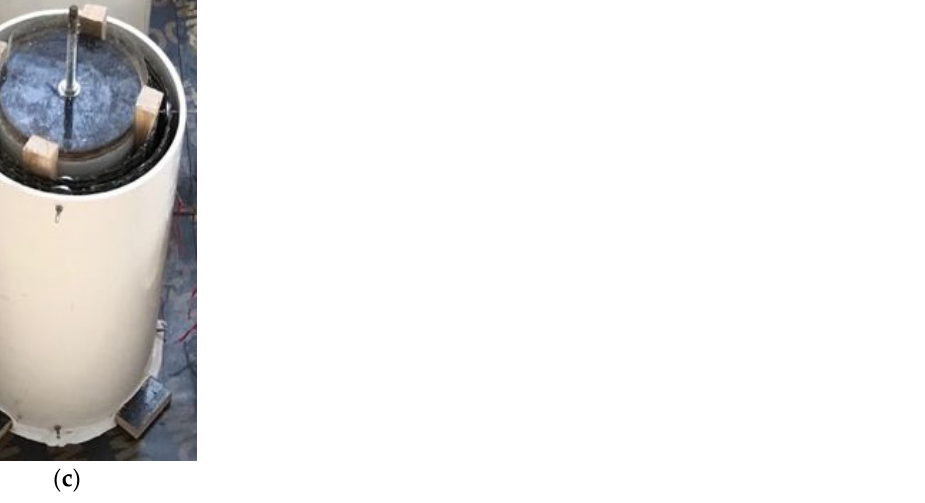
Figure 3. Preparation of formwork for UHPC tubes. ( a ) FRP grid; ( b ) Formwork with a PVC tube; ( c ) Fixed formwork.